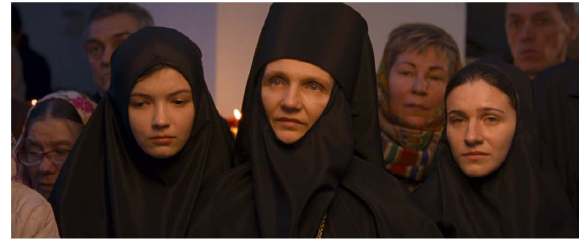
Figure 16. Leviathan (2014).